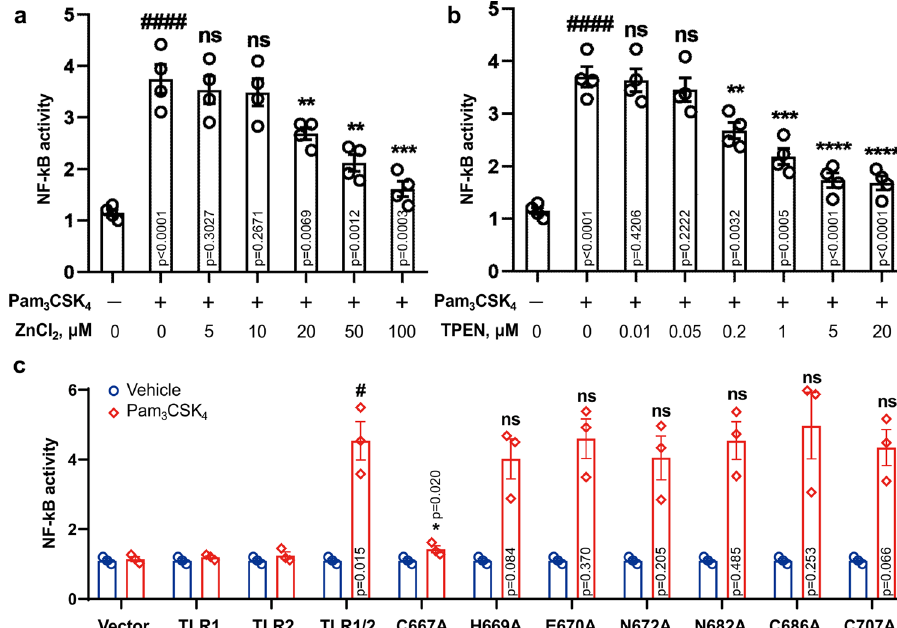
Fig. 5 Role of Zn binding in TLR1 activity. a , b NF- κ B activity measured upon stimulation of HEK Blue 293 cells transfected with TLR1 and TLR2 genes with Pam 3 CSK 4 , with the addition of either 0 – 100 μ M ZnCl 2 or 0 – 20 μ M of TPEN to the culture ( n = 4 independent experiments). c NF- κ B activity measured for TLR1 mutants upon stimulation with Pam 3 CSK 4 ( n = 3 independent experiments). Statistical signi fi cance is indicated as follows: * p < 0.05, ** p < 0.01, *** p < 0.001, and **** p < 0.0001 with respect to the positive control, # p < 0.05 and #### p < 0.0001 with respect to the negative control experiments. ns denotes that changes with respect to the positive control are not signi fi cant. Error bars represent the